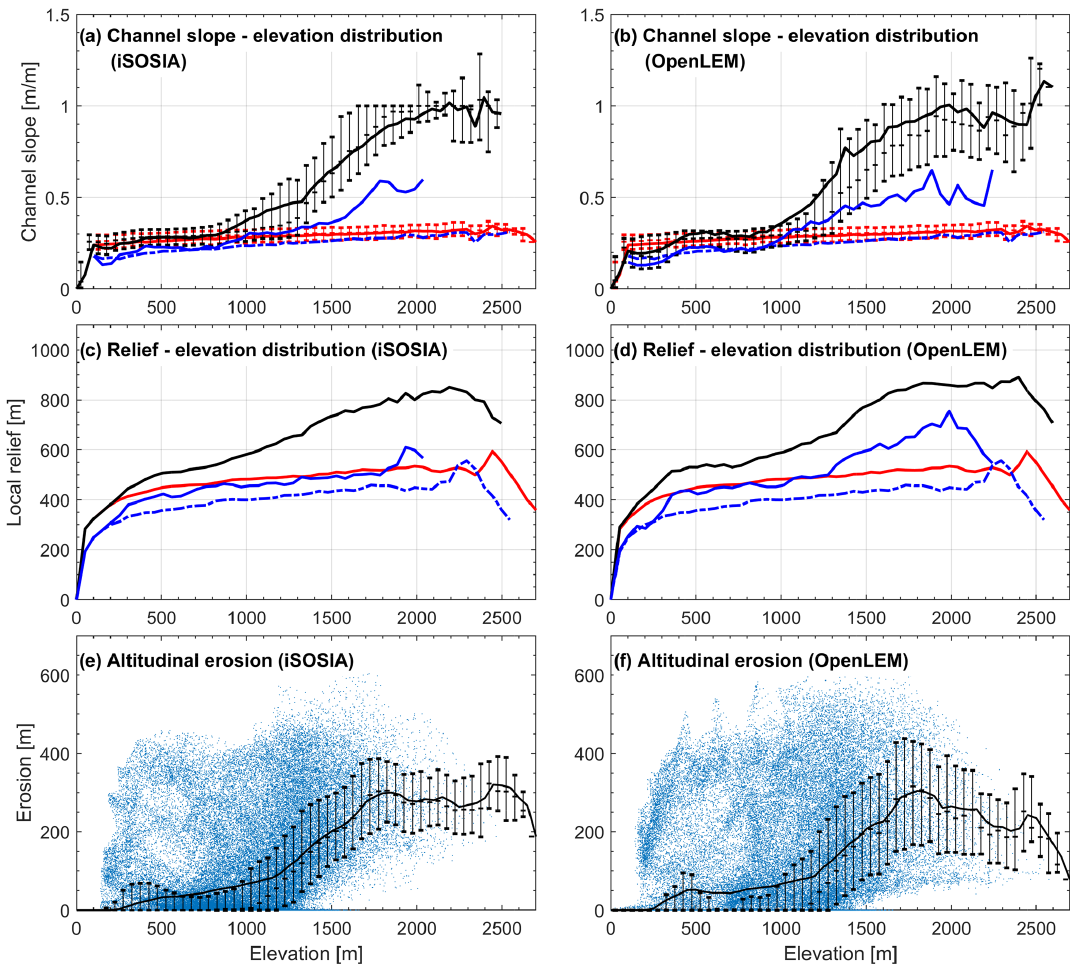
Figure 11. Altitudinal changes in topography. Panels (a) and (b) show channel slope–elevation distributions of iSOSIA and OpenLEM and (c) and (d) present local relief–elevation distributions with local relief as the difference of maximum and minimum elevation within a sliding window with a radius of 1000m. Solid red and black lines represent mean values for the original fluvial and the resulting glacial landscape, respectively. Thin bars show the interquartile range. Solid (glacial landscape) and dashed (original landscape) blue lines show mean values representing the drainage system ( A > 1km 2 ). Mean values and the interquartile range of all plots are derived from elevation bins with a bin size of 50m. (e, f) Altitudinal correlation of erosion. Each blue dot represents the cumulative erosion of a single cell. Black lines indicate the mean accumulated erosion, and black bars represent the interquartile range for the respective elevation